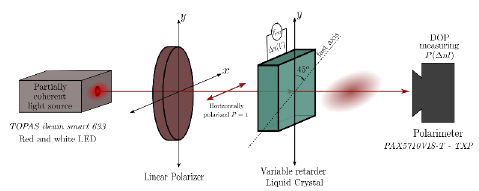
Figure 1. Experimental set up of the depolarization experiment